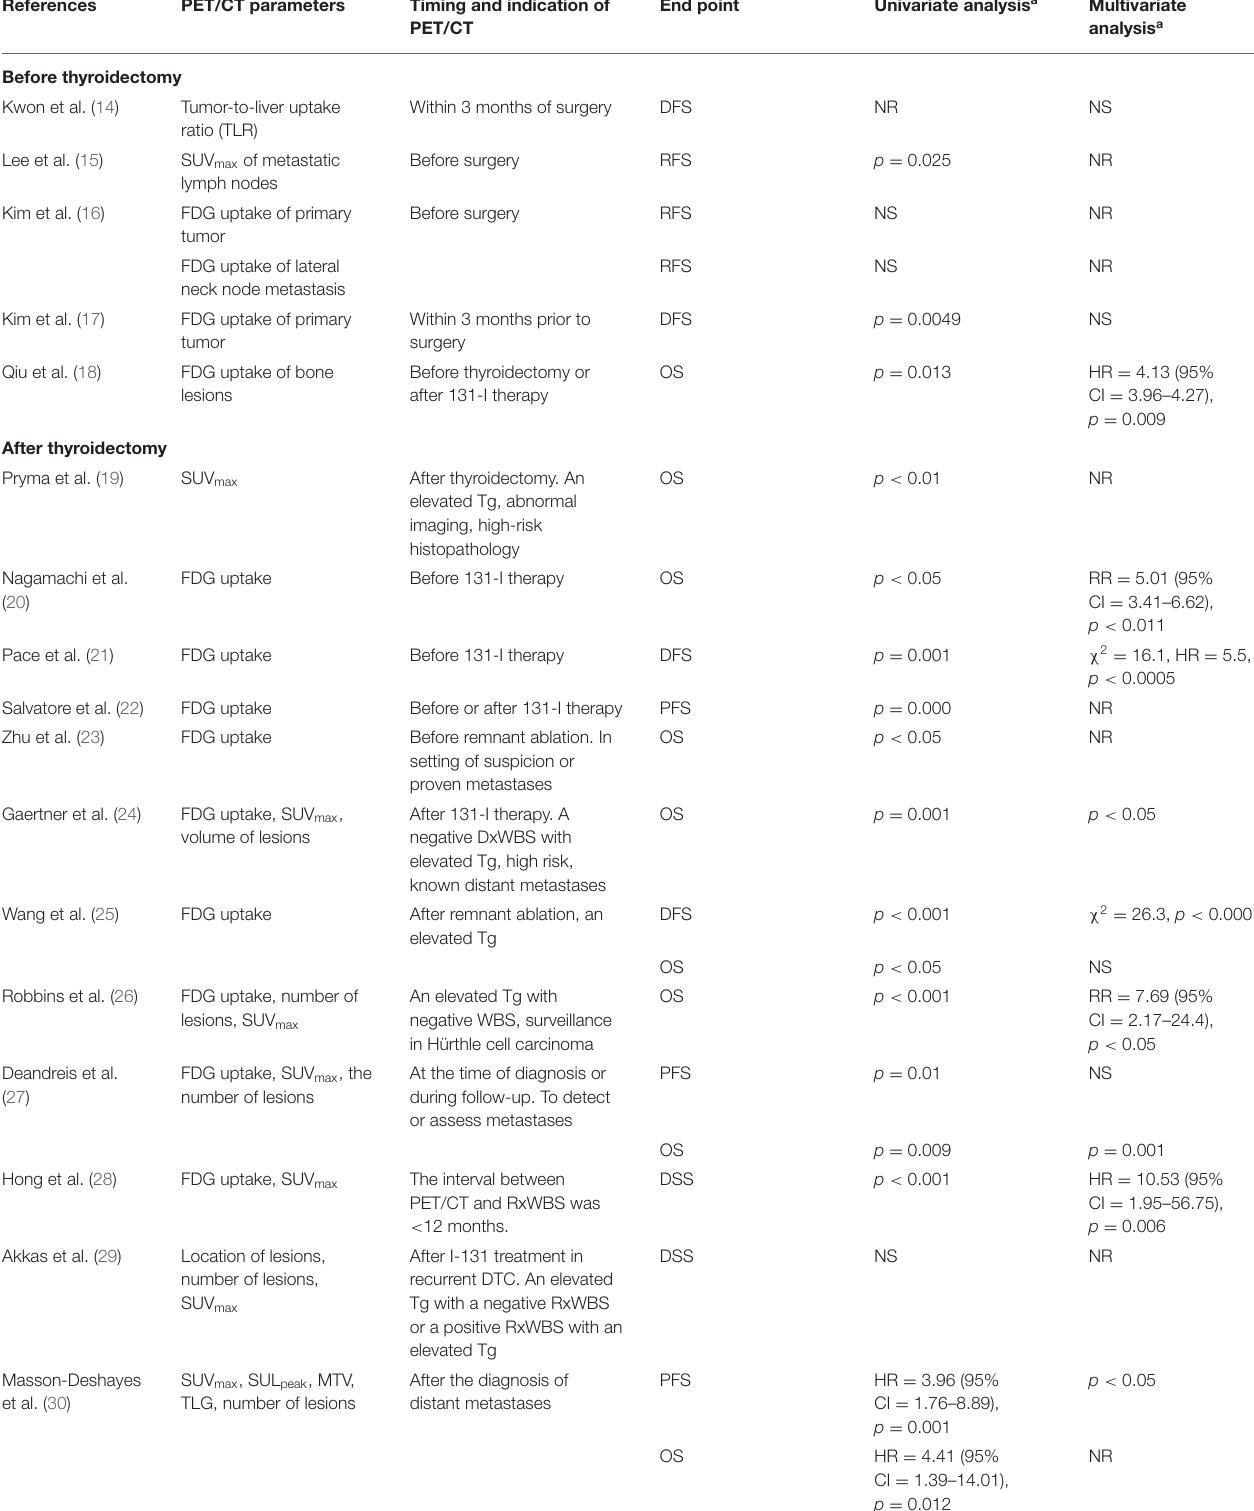
TABLE 2 | Summary of the main results of the included